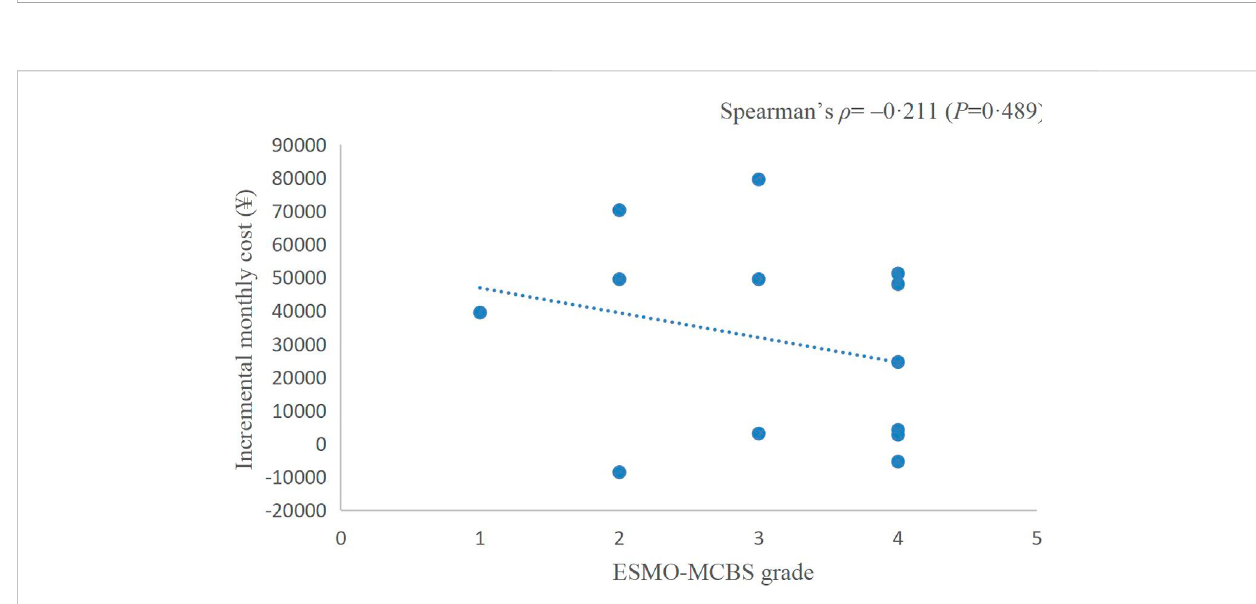
FIGURE 3 Scatterplot of correlation between ESMO-MCBS grades and incremental monthly